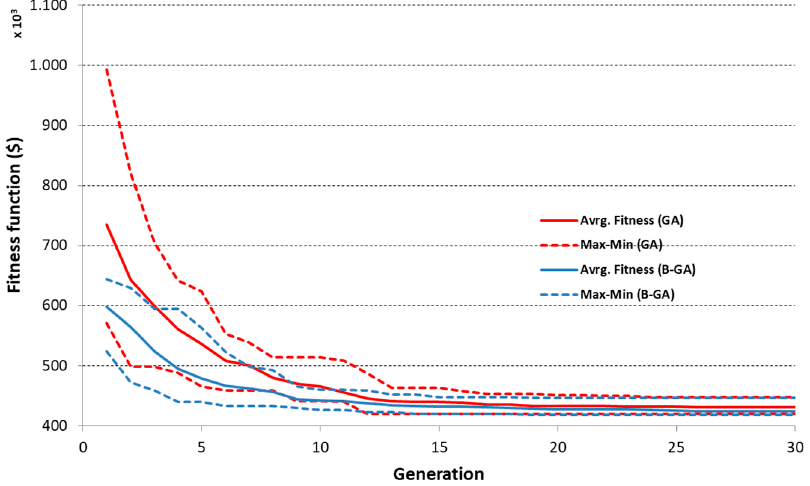
Figure 4. Evolution of the best fitness value for B-GENOME and GENOME algorithms (Alperovits and Shamir Network).